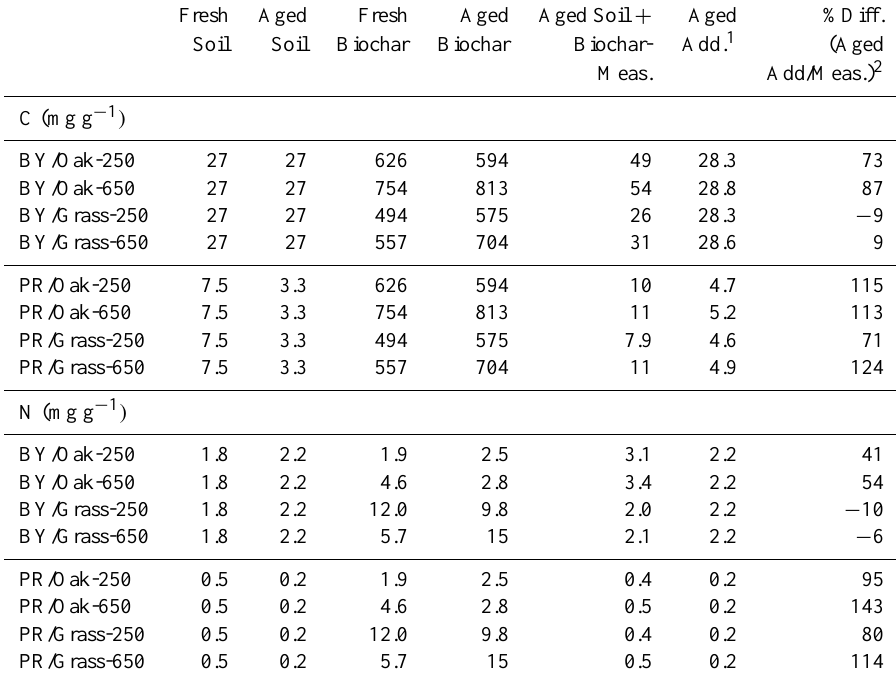
Table 1. Average concentrations of C and N in fresh and 15-month field-aged soils, biochars and soil/biochar mixtures (Meas.) and those predicted by the arithmetic weighted combination of fresh and aged biochar and soil (Add.). Fresh Aged Fresh Aged Aged Soil + Aged %Diff. Soil Soil Biochar Biochar Biochar- Add. 1 (Aged Meas. Add/Meas.) 2